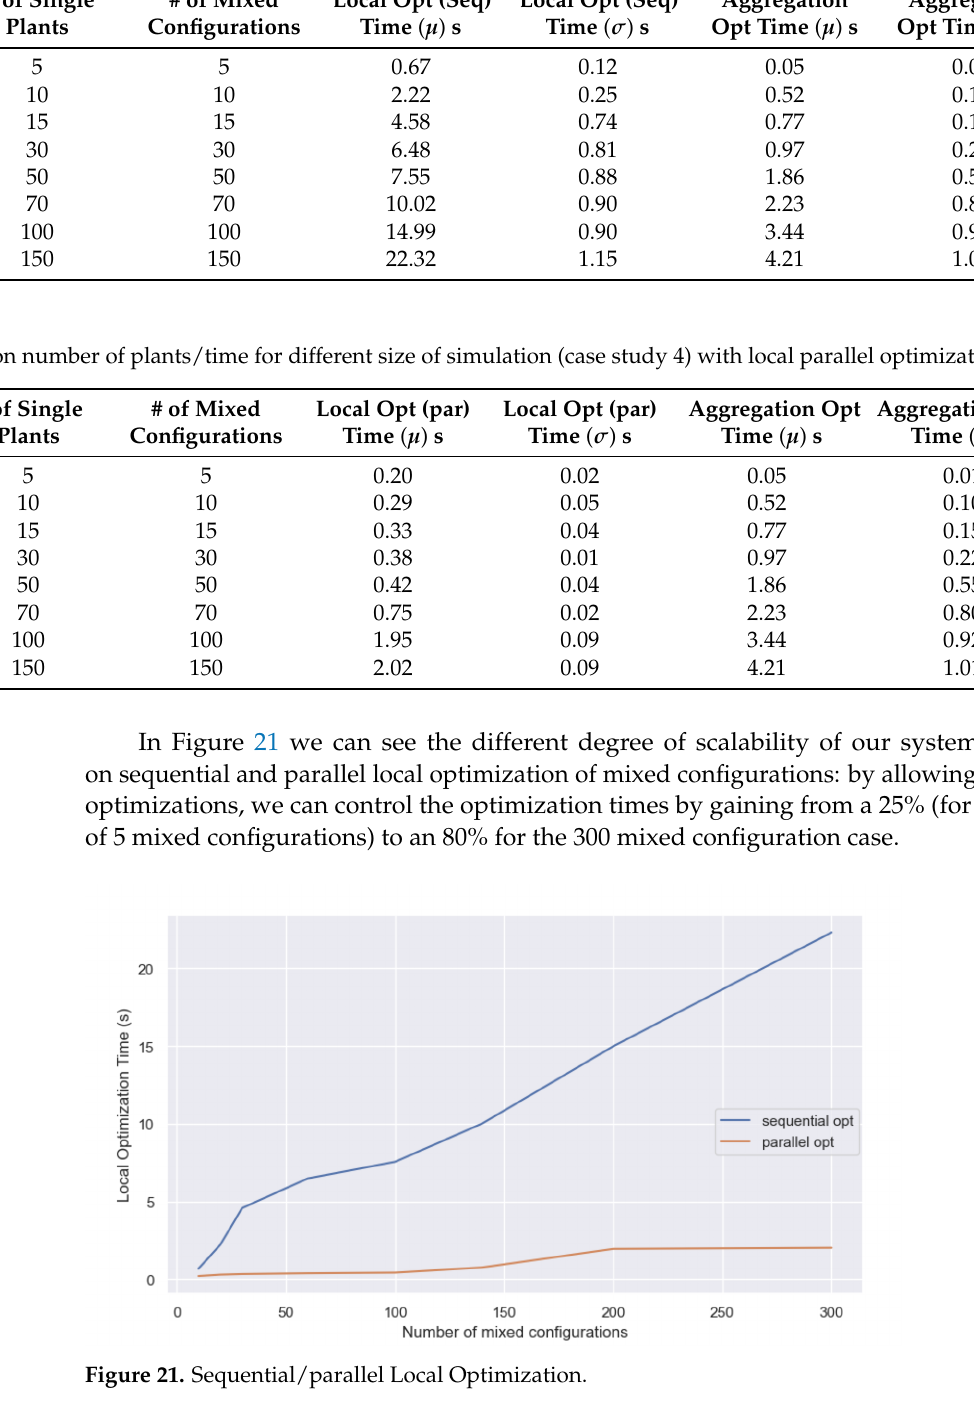
Table 5. Comparison number of plants/time for different size of simulation (case study 4) with local sequential optimization. Simulation